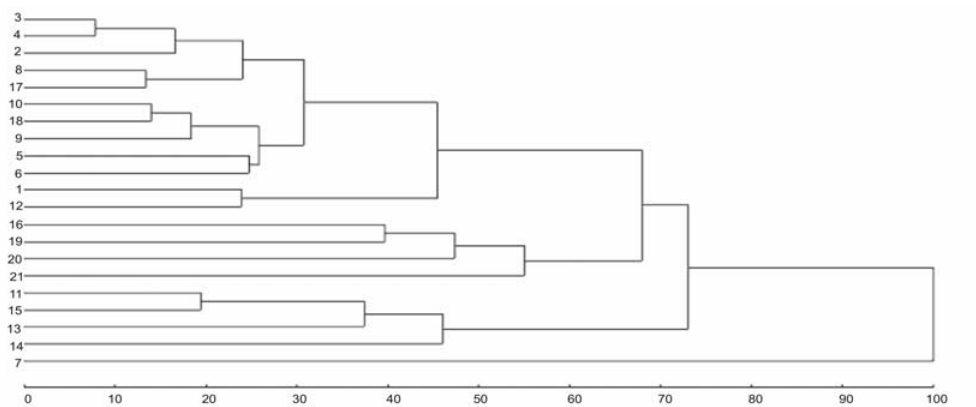
Figura 1. Dendrograma da similaridade entre os 21 tratamentos (Quadro 1), obtidos pelo método da ligação média entre grupos (UPGMA), com base na distância generalizada de